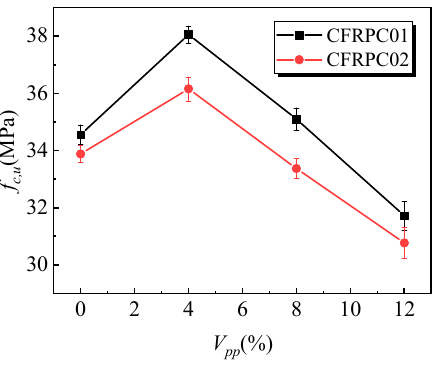
Figure 4. Effect of the polymer–cement ratio on the compressive strength of the specimens.